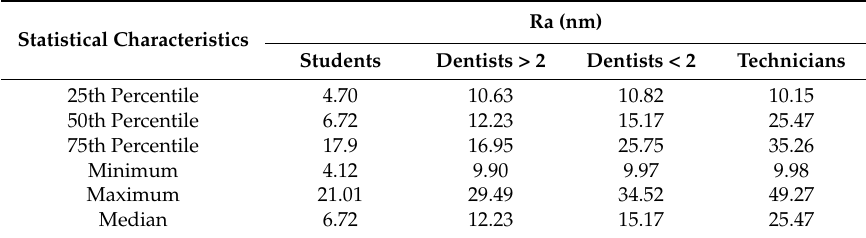
Table 1. Descriptive analysis of the Ra values (nm) of investigator 1 and trial one achieved by the specific practitioner groups.